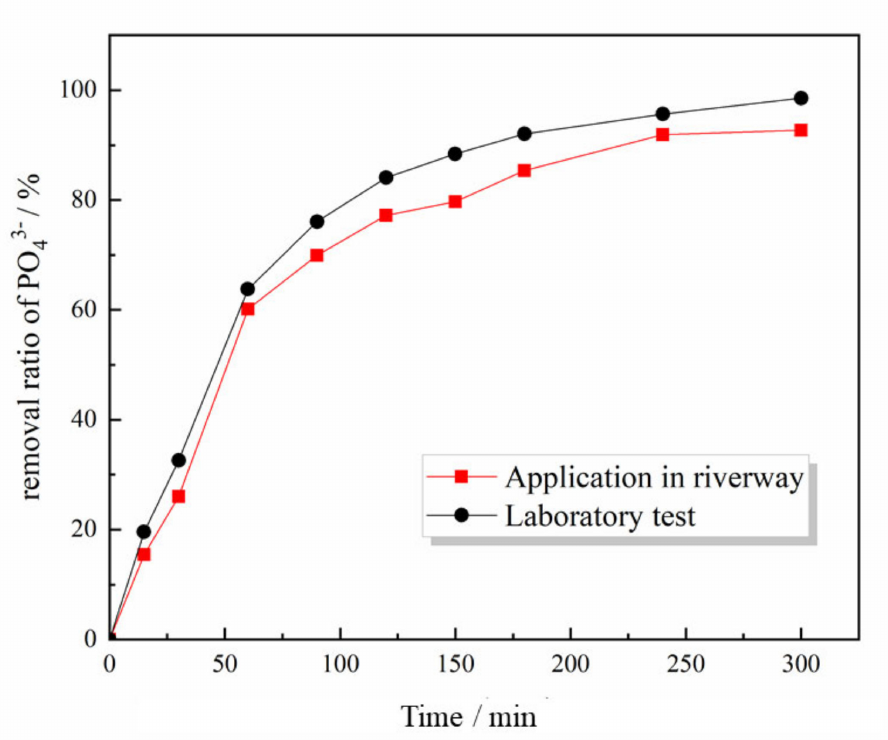
Figure 10. The efficiency of the Reactor under actual